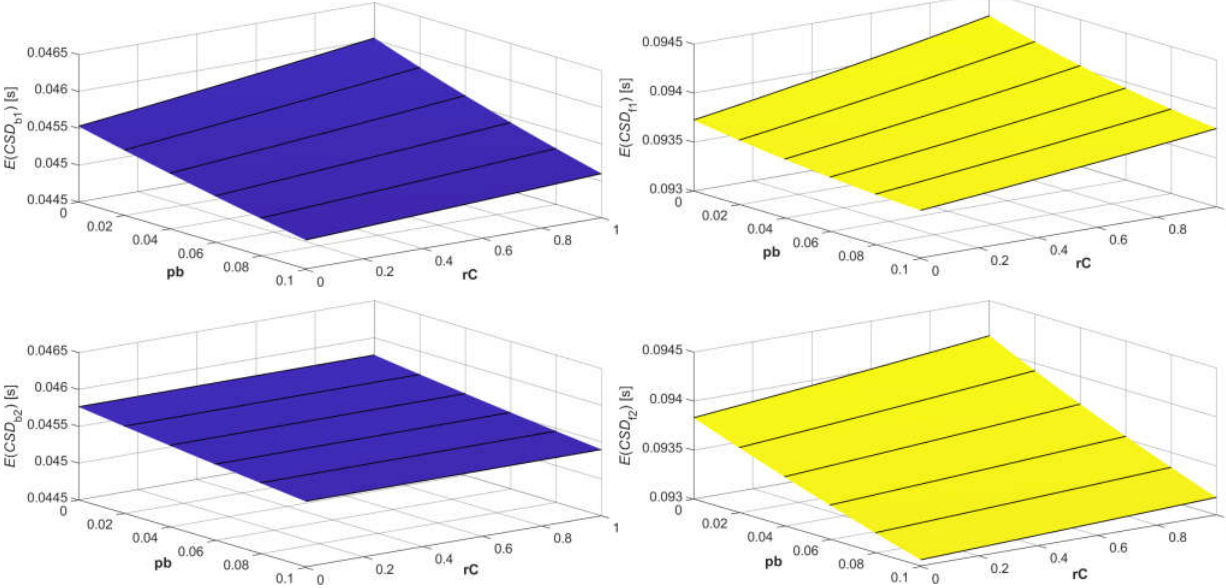
Figure 9. Selected results for data set 6 from Table 1.